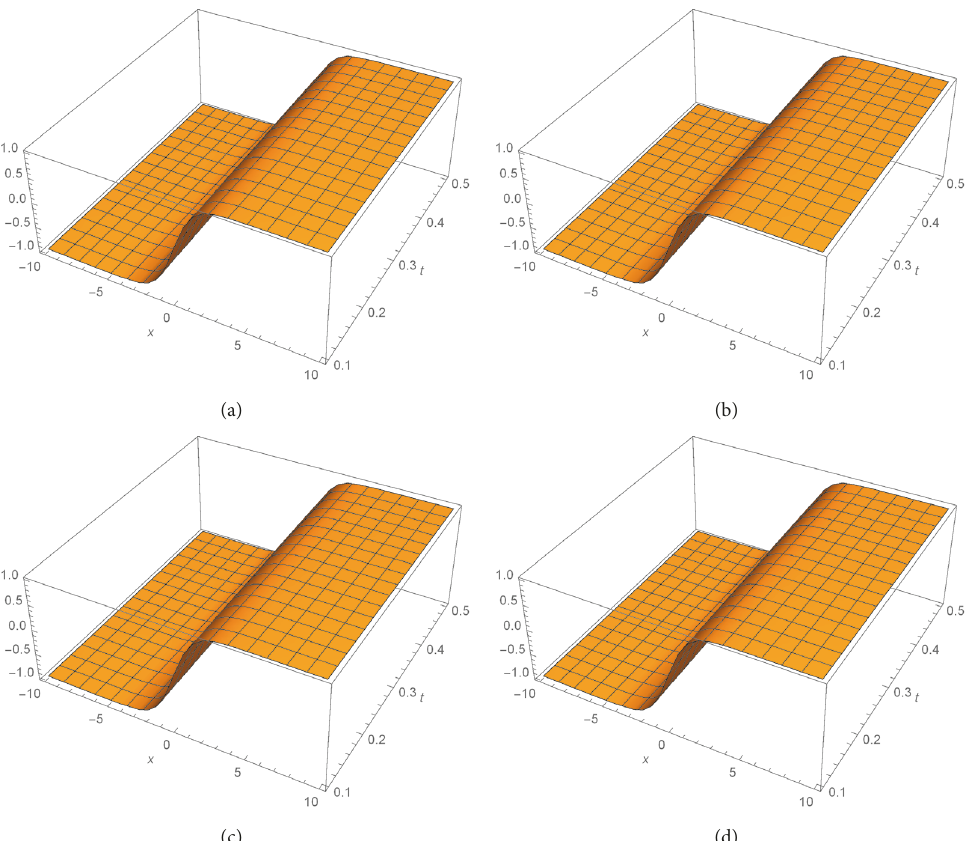
Figure 4: The approximate solution for fractional Chan-Hilliard equation: (a) 𝛼 = 1 , (b) Exact solution, (c) 𝛼 = .99 , and (d) 𝛼 = .95 .